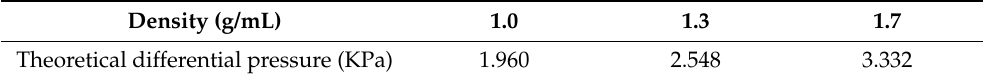
Figure 11. Chart showing the changes in detection error with inlet velocity corresponding to different liquid densities. Table 2. Theoretical differential pressures corresponding to liquids of different densities ( ∆ H = 20